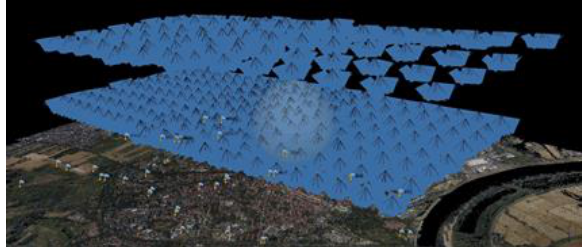
Figure 2: Results of the joint AT of all cameras and both flight